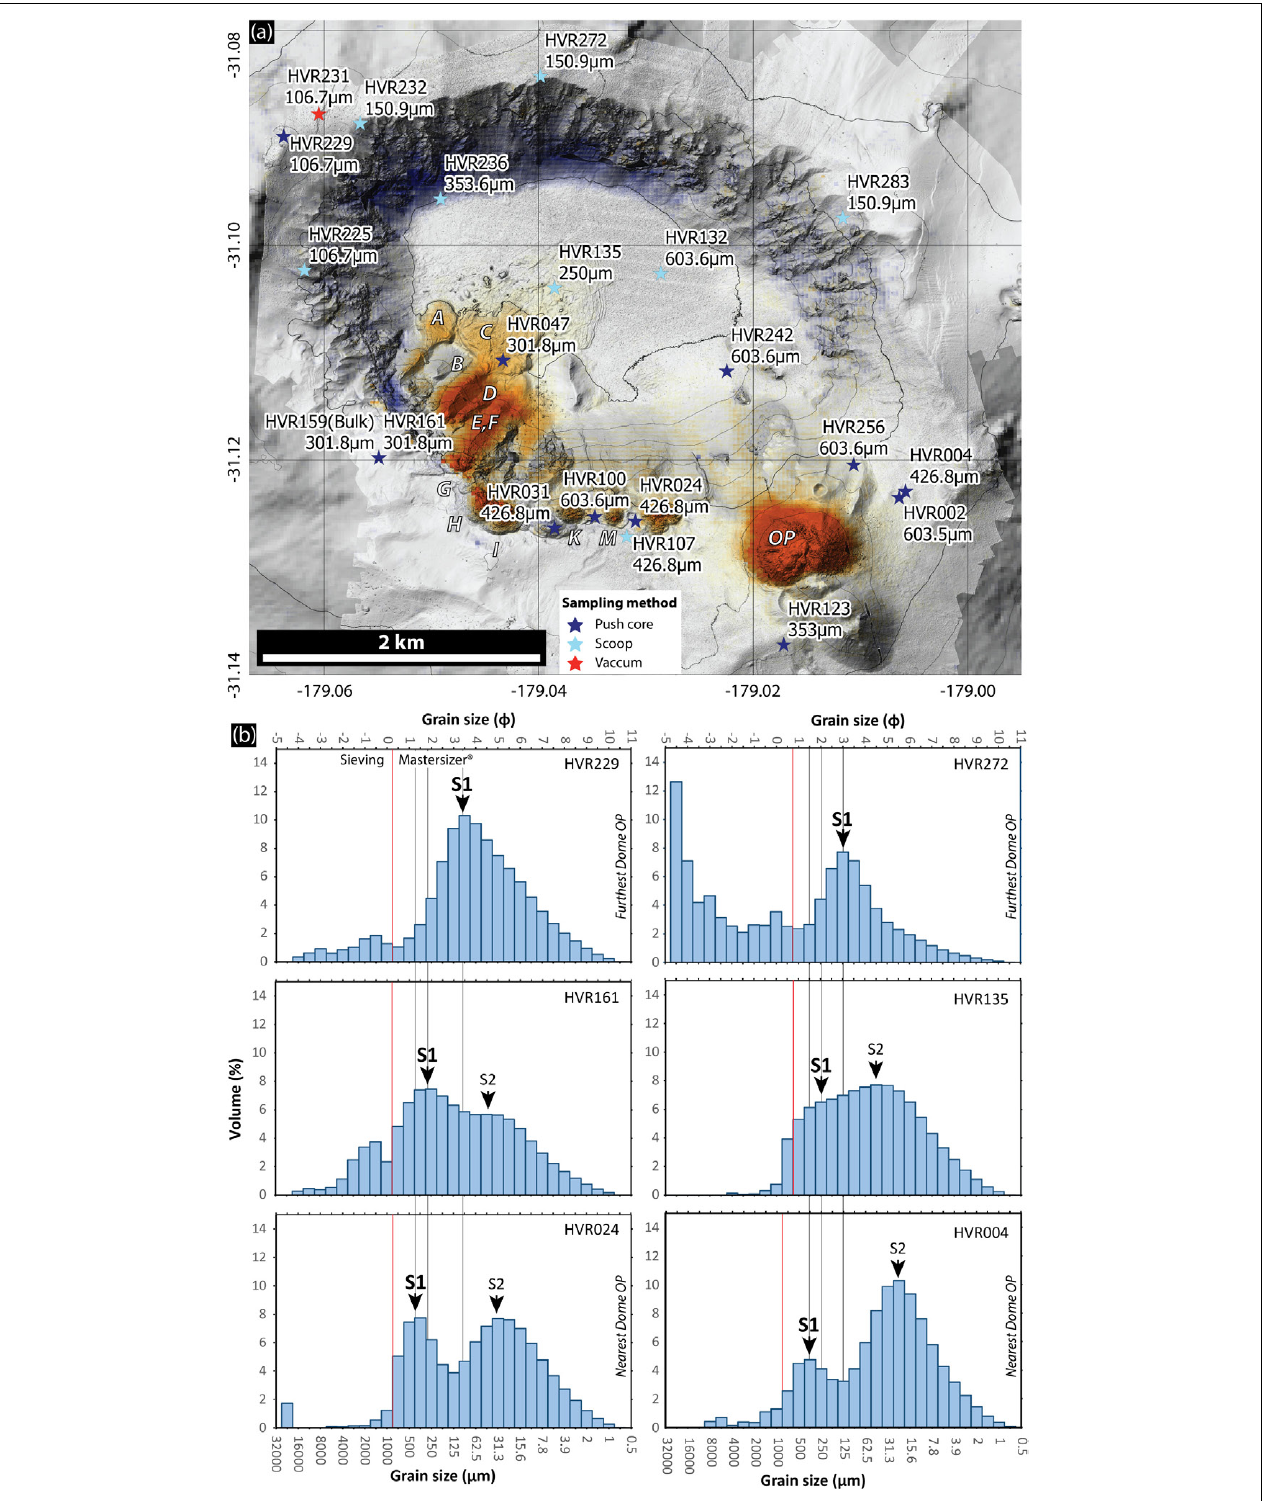
FIGURE 4 | (a) Sample numbers and grainsize peaks for samples of the AL unit from 0.25 ϕ ( ∼ 240 µ m) and 3.5 ϕ ( ∼ 88 µ ), inferred to represent S1, across the Havre caldera. (b) Representative grain size distributions for samples of the AL unit, with samples closest to Dome OP at the bottom and samples farthest away at the top. The dark lines on the graphs show the location of the inferred S1 peak in each sample for comparison across the caldera. Note the lack of the 5–6 ϕ mode on the northern caldera rim in samples HVR229 and HVR272.